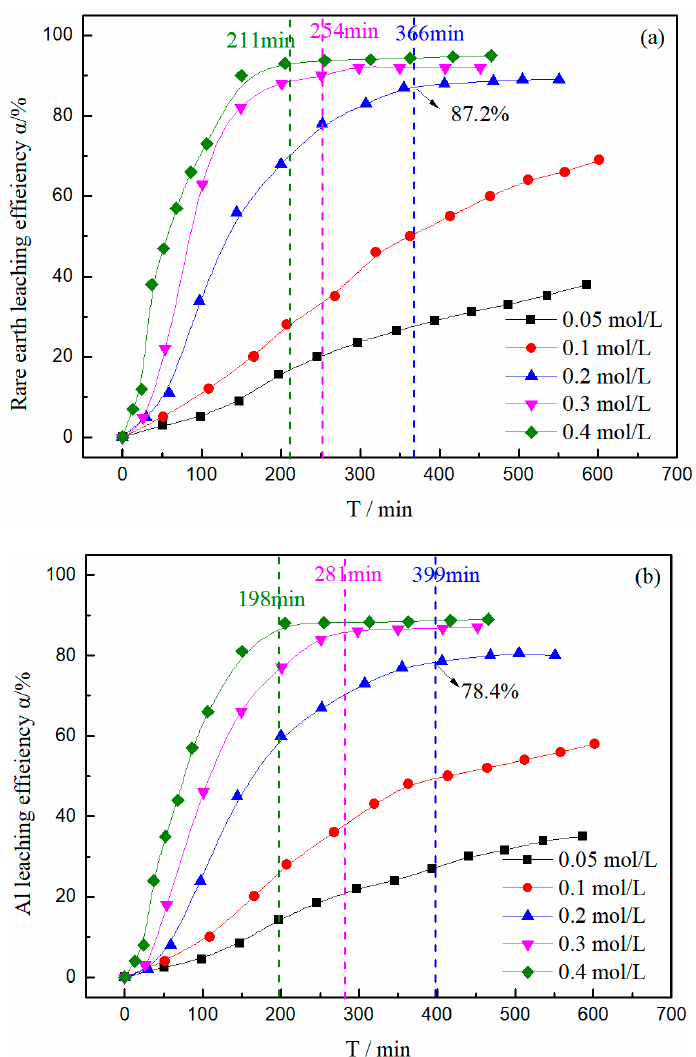
Figure 5. Leaching kinetics of RE and Al with different magnesium concentrations: ( a ) RE and ( b ) Al (250 g ore; liquid: solid = 1.2:1; flow rate = 0.5 mL/L; pH = 5.6; room temperature).